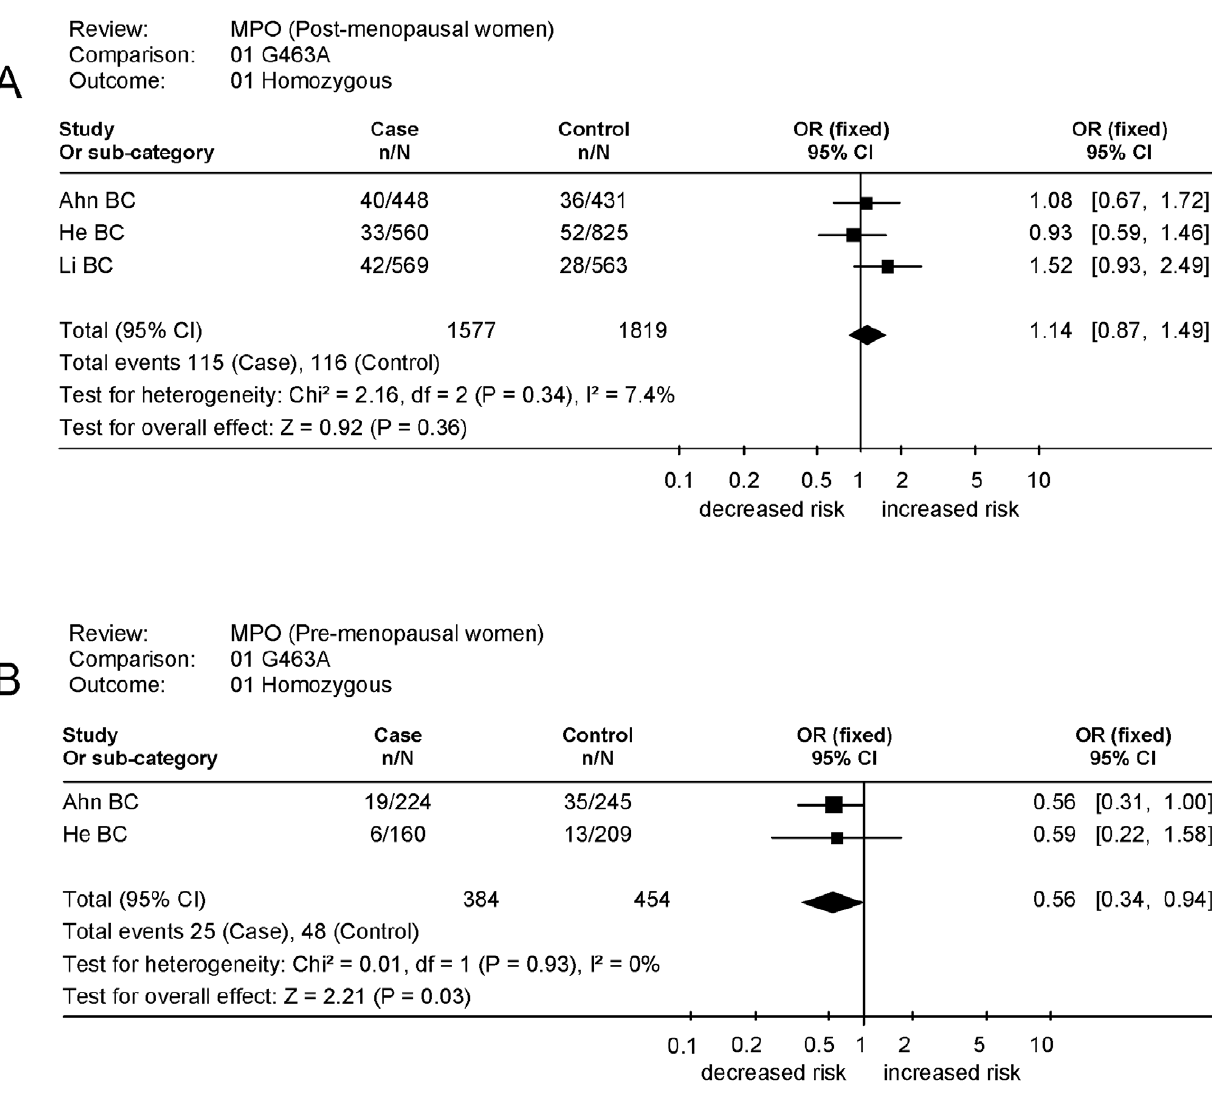
Figure 2. Forest plots of the odds ratios and confidence intervals of breast cancer associations in the homozygous model for (A) post-menopausal and (B) pre-menopausal